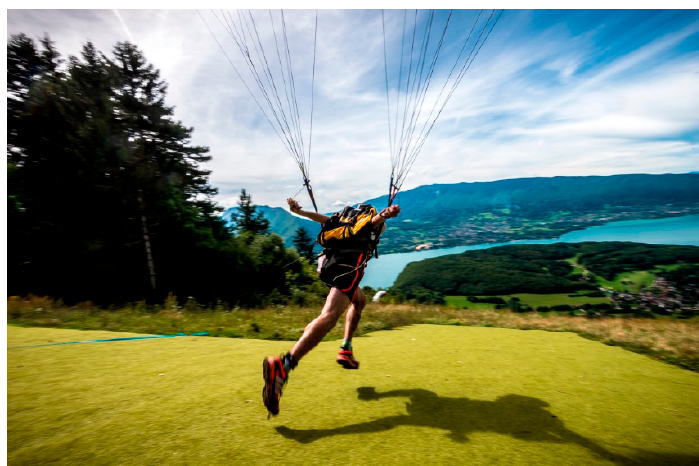
Figure 8. A (non-flapping) paraglider mimics the running action while a protobird actually flies at level lift-off. A casual observer would be challenged to distinguish between the running and the flying [10].